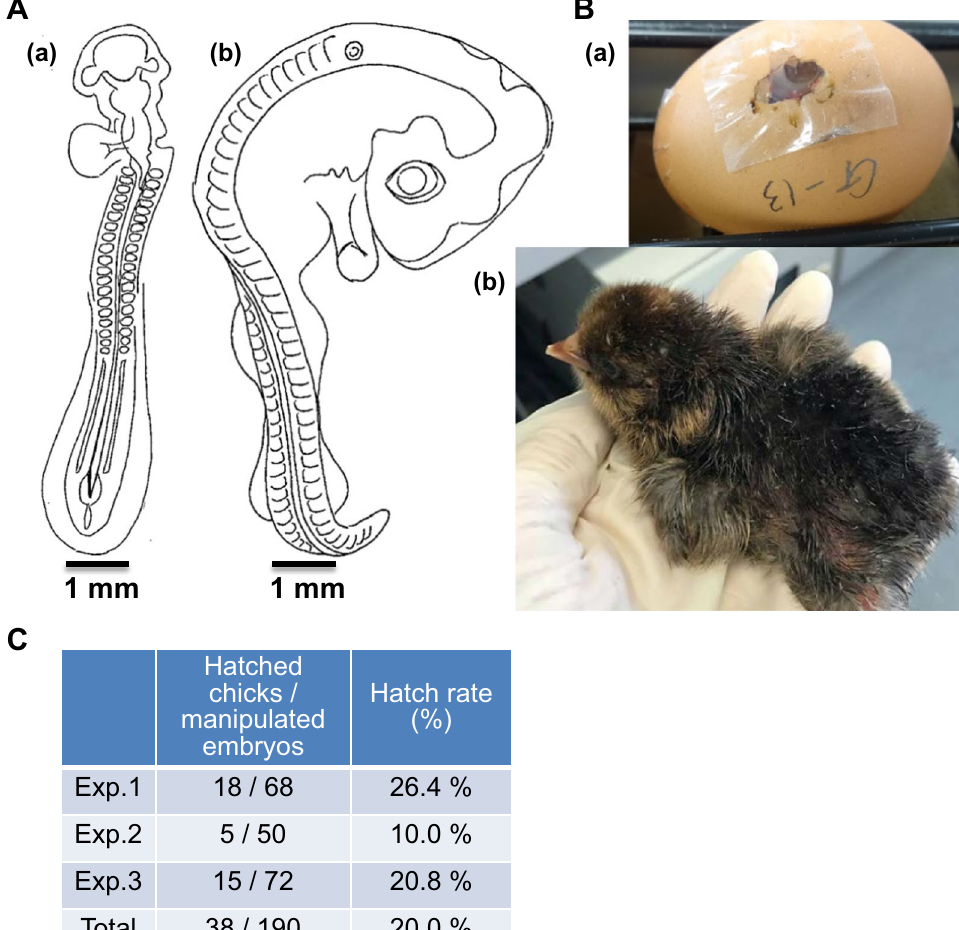
Fig. 5 Manual implantation of fluorescent beads into the head area of chick embryos. A Stage-13 and -18 embryos. Chick embryos at stages 13 (a) and 18 (b), taken from the textbook (Bellairs and Osmond 2005). B A photograph of one of the first hatched chicks after inoculation. (a) After implanting the micro-beads into the embryos, the eggshells were sealed with tape. Then the manipulated embryos were incubated until hatching. (b) The first animal to have micro-beads in its brain at birth. C The hatch rate of the inoculation experiments. Results of three